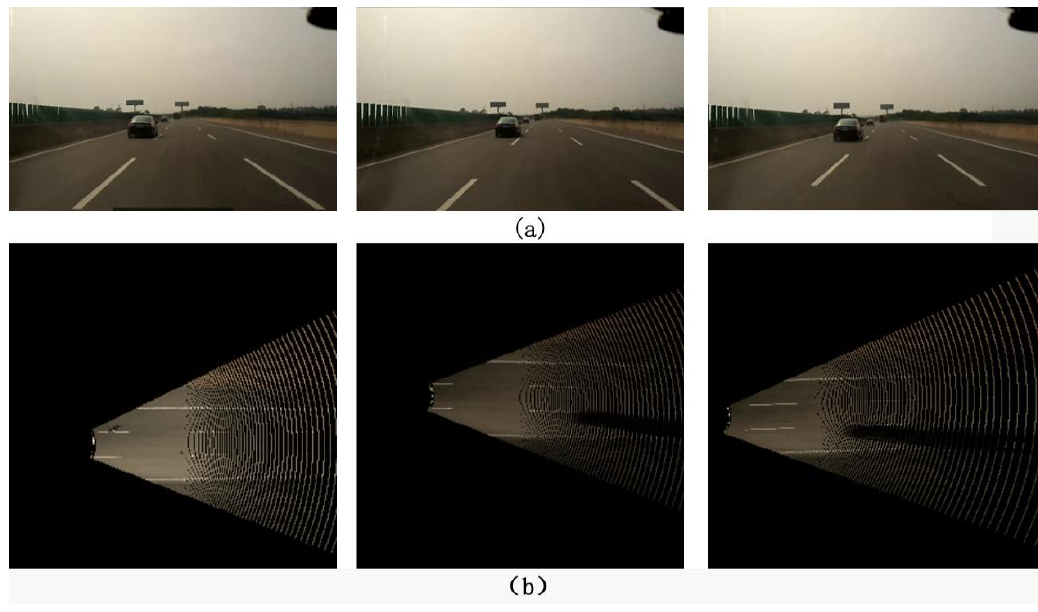
Fig 8. Experiment result, figure a is the original image, figure b is the result of 3D